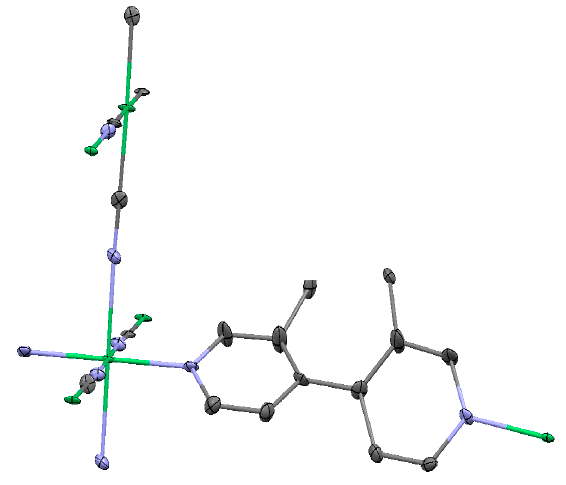
Figure 9. The basic motif of the Ni(BpyMe)[Ni(CN) 4 ] molecules (C-grey, N-blue, Ni-green; probability ellipsoids drawn at 50%).